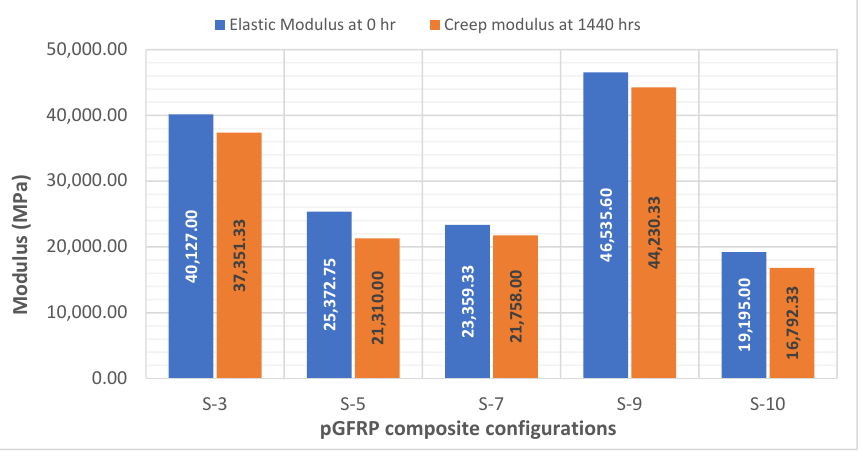
Figure 7. Changes of creep modulus between initial and final periods for all pGFRP composite configurations.